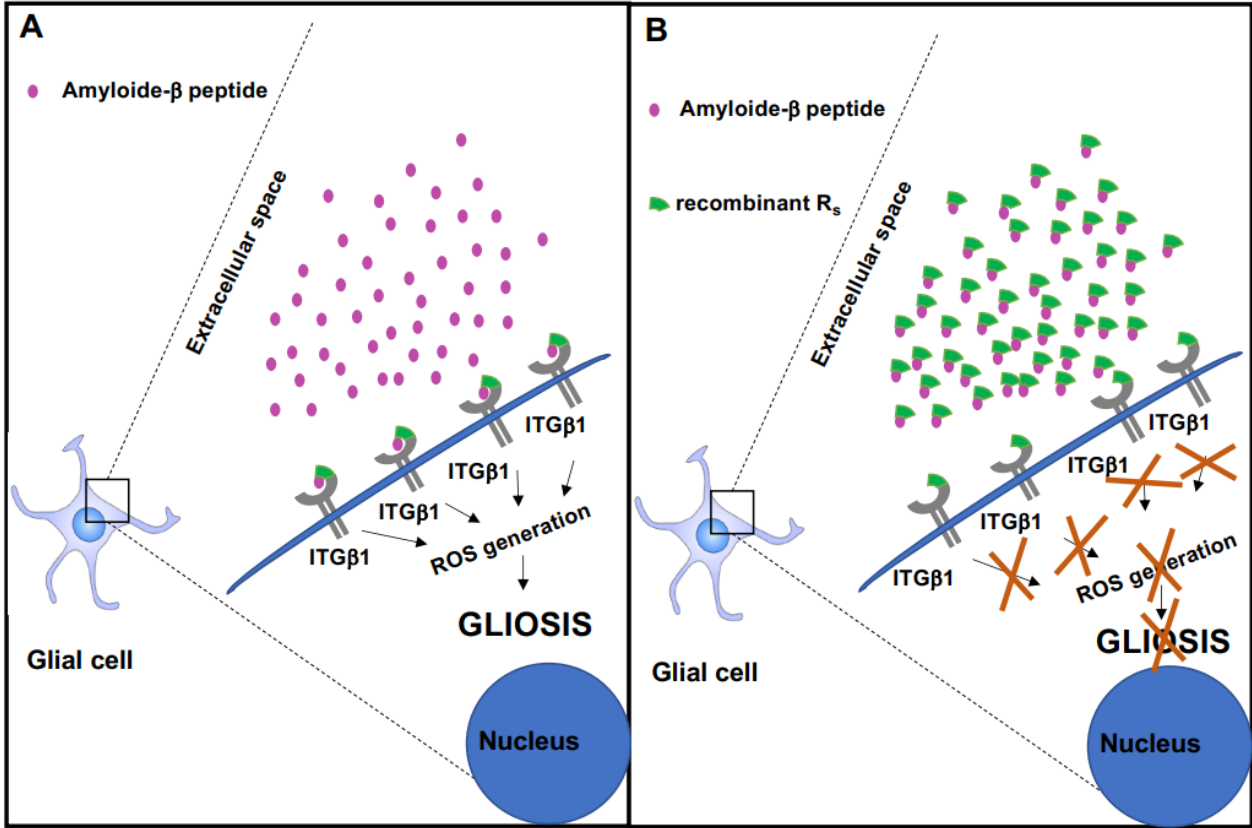
Figure 6. Functional model of recombinant Rs peptide to prevent the toxic effect from amyloide β peptide. ( A ) Amyloide β peptide from the extracellular space binds to integrin β 1 and triggers the activation of intracellular signaling pathways that lead to the generation of reactive oxygen species and gliosis. ( B ) Recombinant R s peptide and amyloide β peptide interact with each other; and in these circumstances, amyloide β peptide cannot bind to the R s region of integrin β 1 and does not activate the signaling pathways that lead to ROS generation and gliosis.